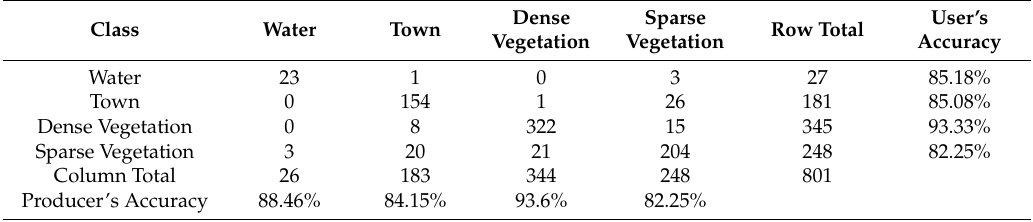
Table 2. Confusion / error matrix of land use / land cover classification of the Cape Coast Metropolis.